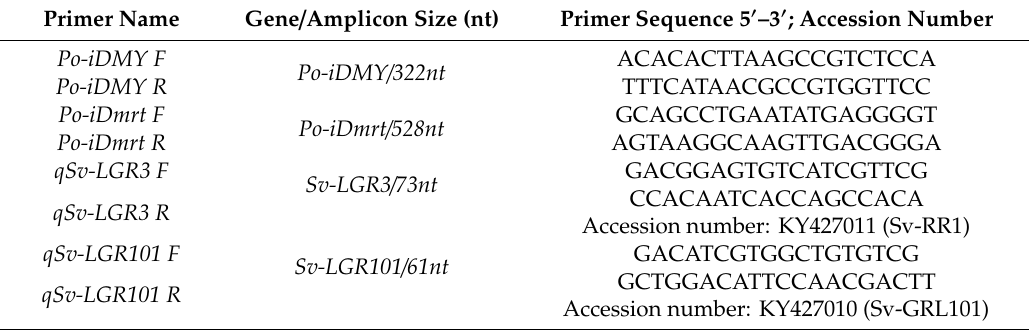
Table 1. Primers used in this